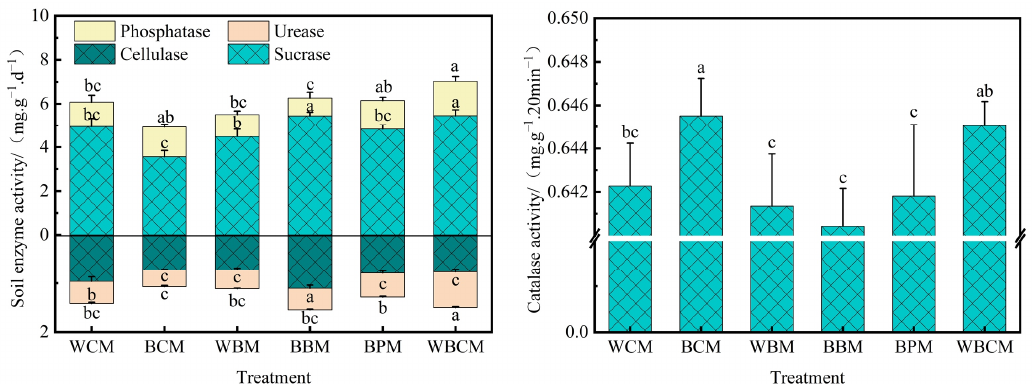
Figure 6. Effects of different treatments on soil enzyme activity. Error bars represent ±SD. Values followed by the same letter within a column in each year are not significantly different at p ≤ 0.05, as determined by the HSD test.